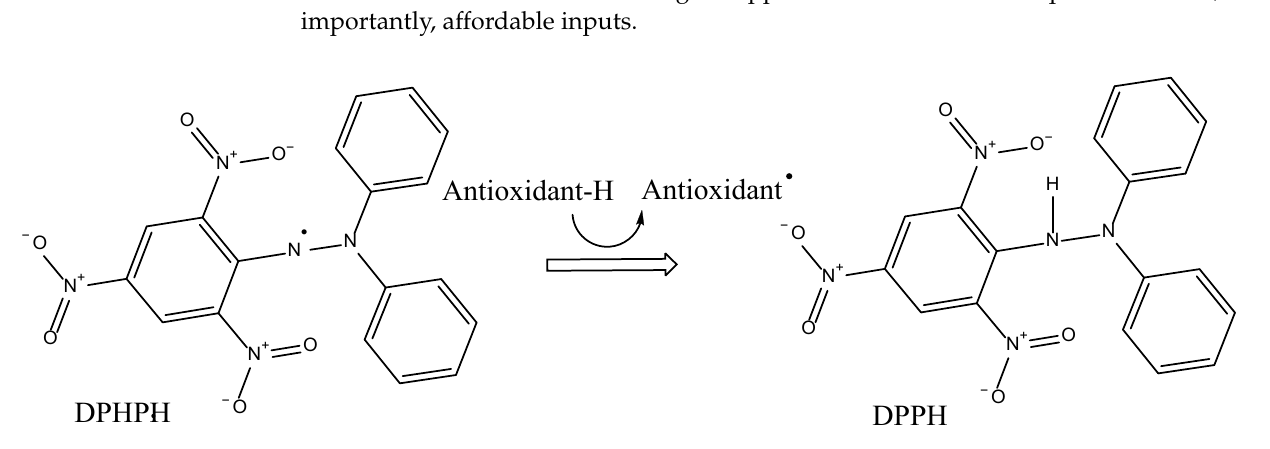
Figure 8. Theoretical mechanism of DPPH in the presence of an antioxidant [80,88].